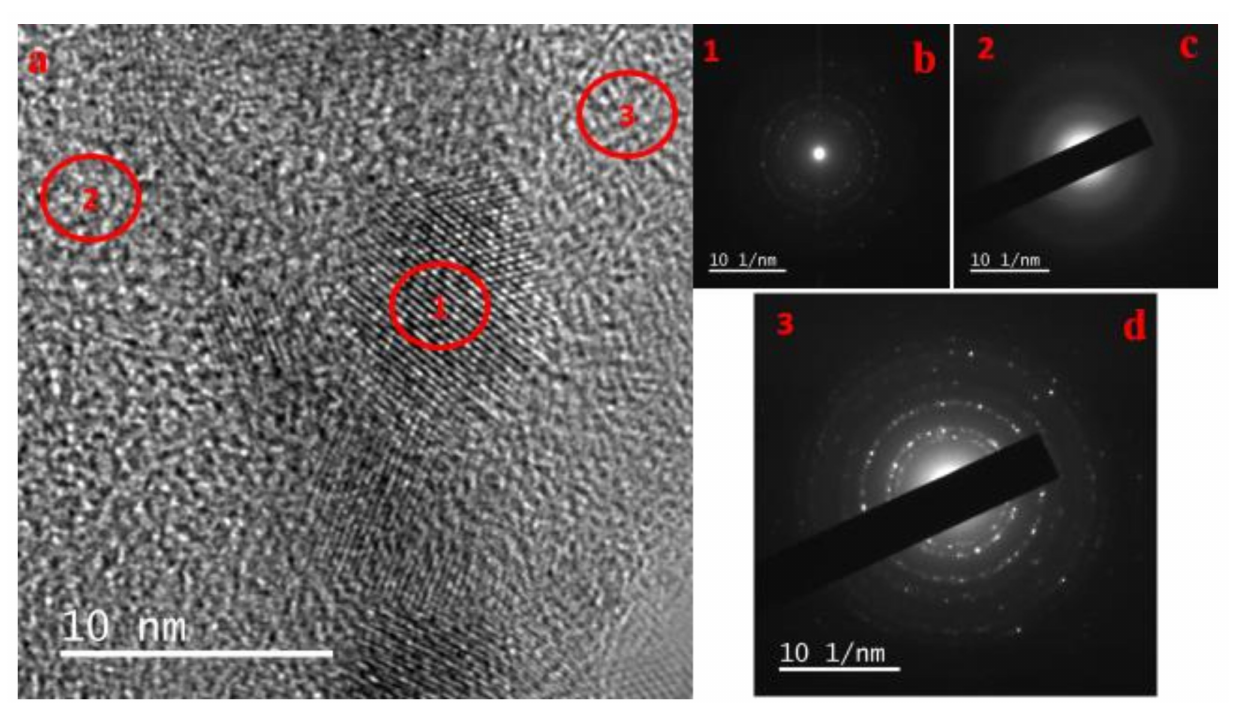
Figure 3. HRTEM images of ( a ) WS 2 -PANI-5 at 10 nm, ( b – d ) SAED pattern of WS 2 -PANI-5 of three different spots 1, 2, and 3.